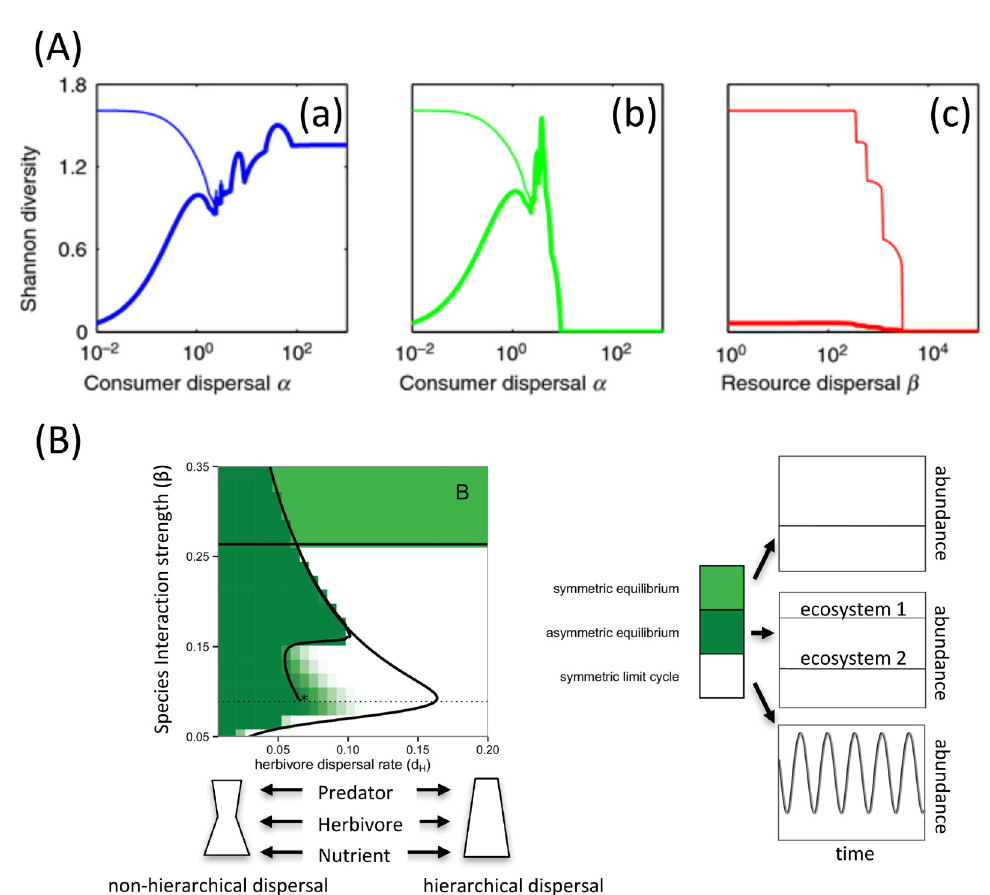
Figure 1. Role of spatial interaction strength across trophic levels for dispersal-diversity relationships and for regional stability. ( A ) Diversity–dispersal relationships. (a) Consumer dispersal α varies while keeping resource dispersal β small. (b) Consumer dispersal α and resource dispersal β vary simultaneously. (c) Resource dispersal β varies while keeping consumer dispersal α small. Thick line: local diversity; thin line: regional diversity. Reprinted with permission from John Wiley & Sons, Inc. 30 . ( B ) Changes in qualitative dynamics in a two-patch tri-trophic meta-ecosystem from varying resource intra-specific interaction strength ( β ) and dispersal rates, holding all other parameters constant. At intermediate levels of β , making dispersal more non-hierarchical by decreasing middle-trophic-level dispersal rates ( d ) leads to increased stability because of the emergence of stable asymmetric equilibria. Reprinted with permission from the H University of Chicago Press Books 31